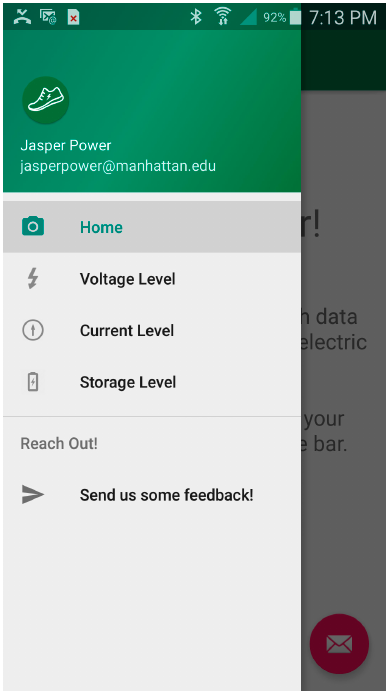
Figure 13. Jasper Power Side Menu.